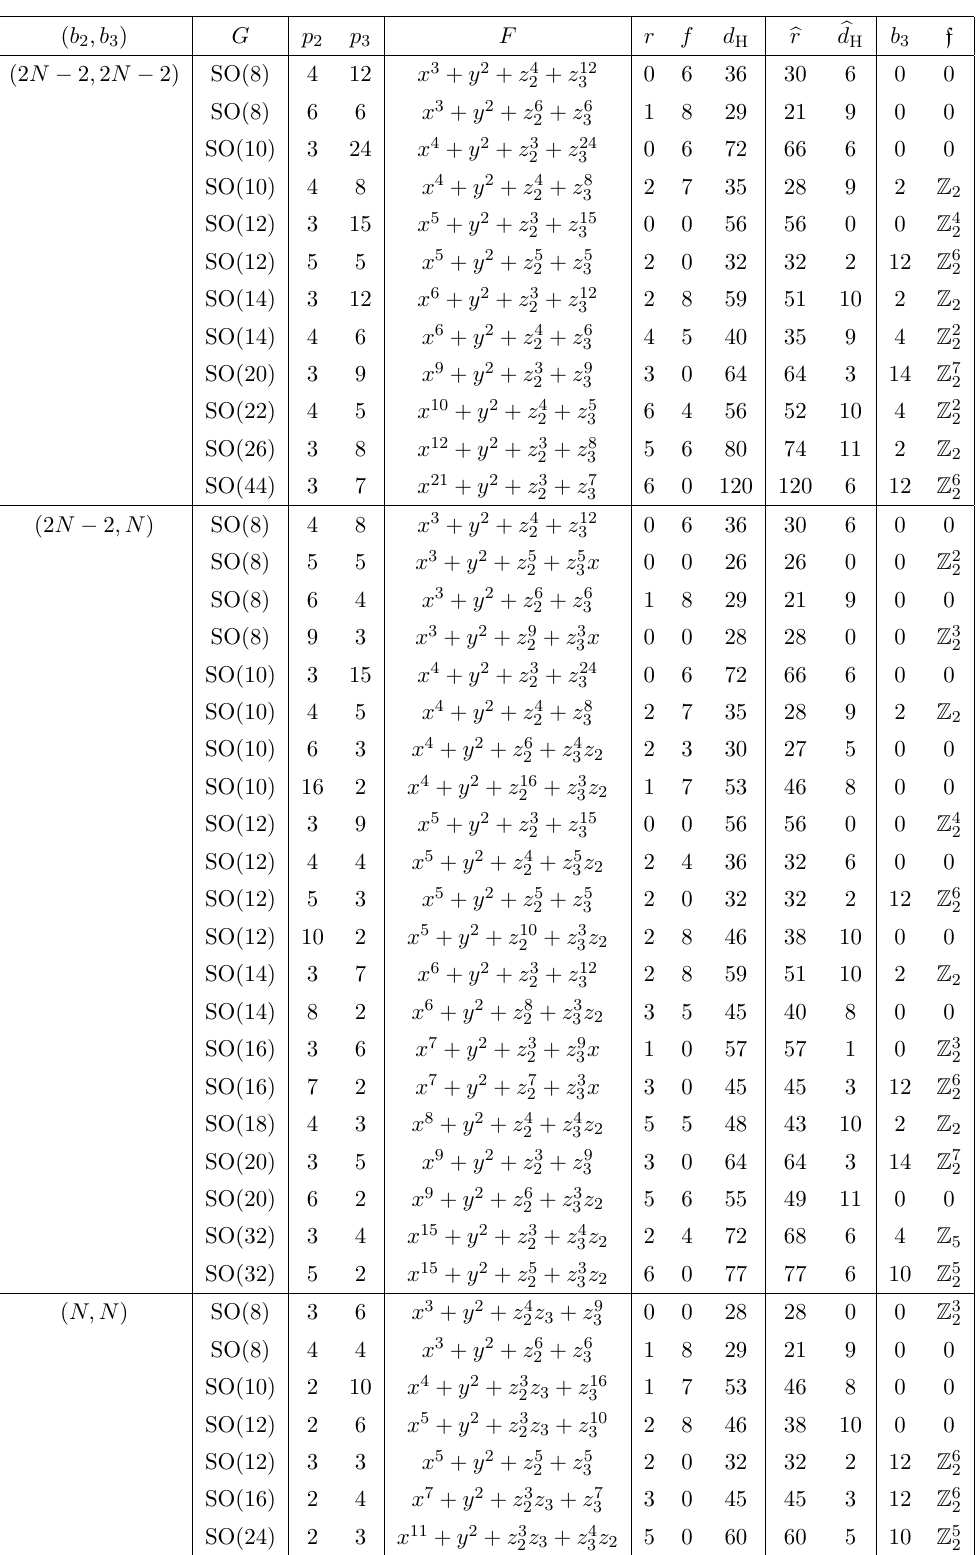
Table 20 . G = SO(2 N ) models with b 1 = N , p 1 = 1